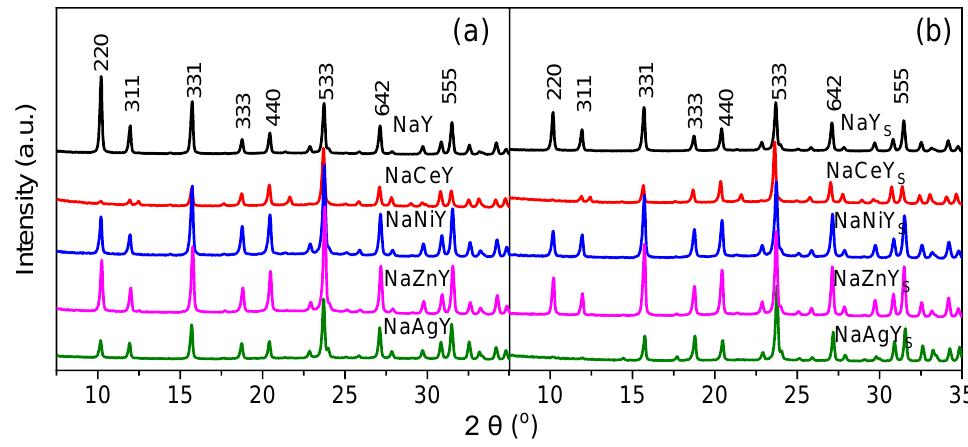
Figure 6. XRD patterns of Y zeolites before ( a ) and after ( b ) desulfurized in simulated COG at 100 °C.